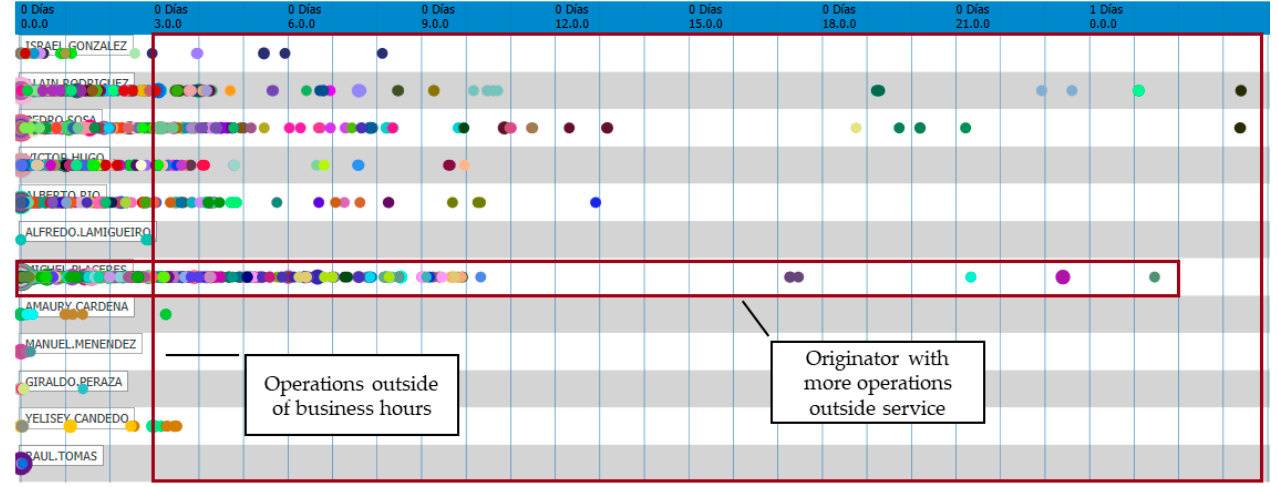
Figure 8. View by the originator of the executed operations.